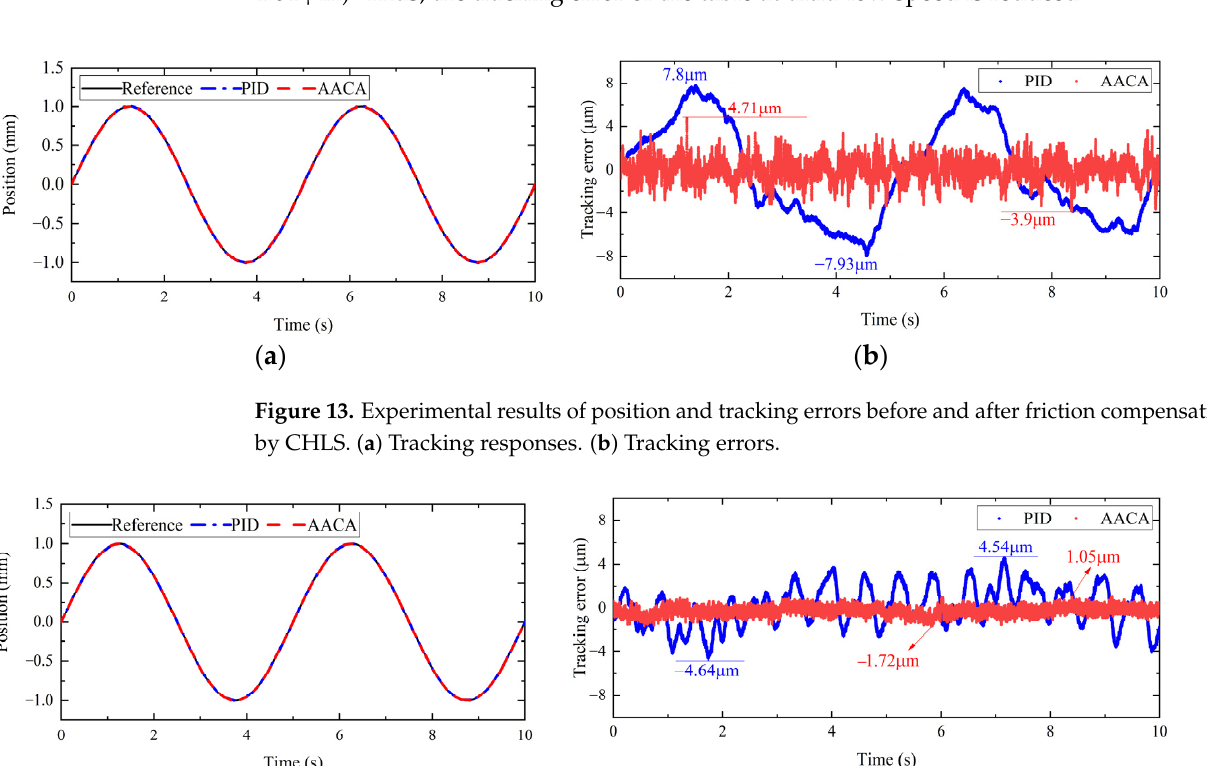
Figure 14. Experimental results of position and tracking errors before and after friction compensation